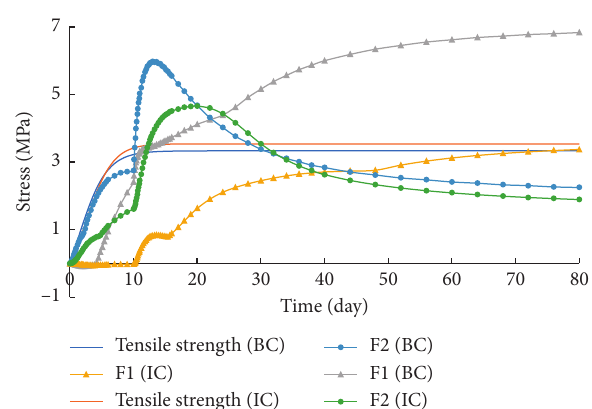
Figure 13: Stress duration curve of key points F1 and F2 of sluice floor.